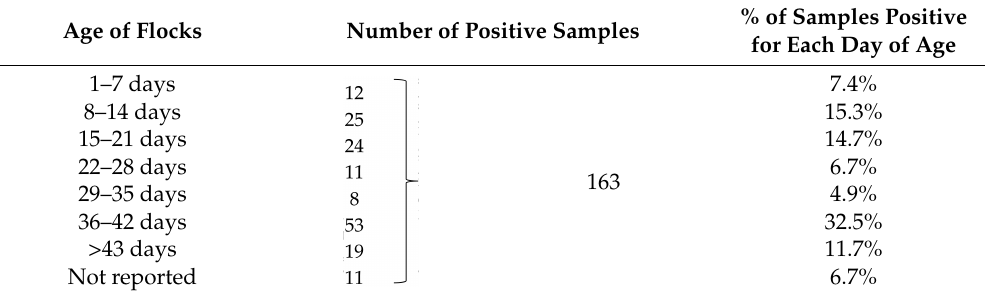
Table 5. Number of positive samples according to the age of